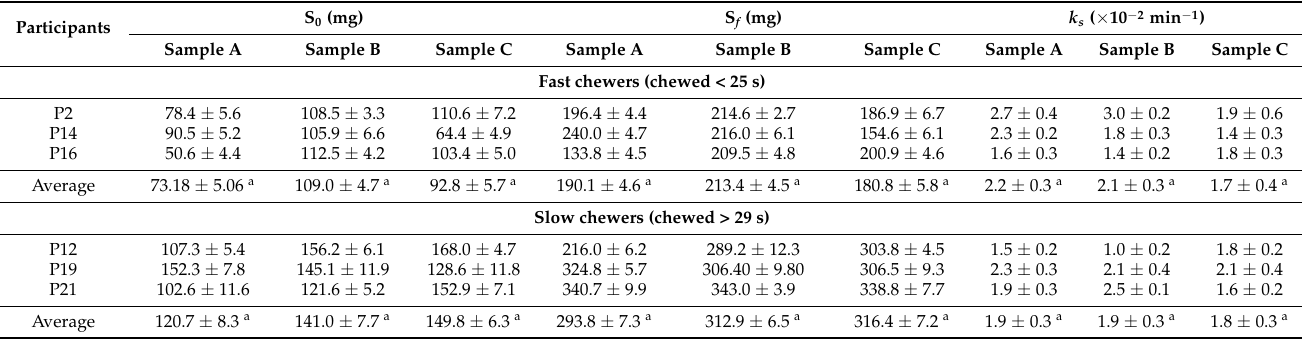
Table 4. Kinetic parameters of in vitro small intestinal starch digestion of in vivo masticated oral boluses of the black bean samples (A: PEF and thermally processed without CaCl 2 addition; B: PEF and thermally processed with CaCl 2 addition; and C: No PEF, thermally processed with CaCl 2 ) from selected fast and slow chewers as estimated using fractional conversion model (Equation